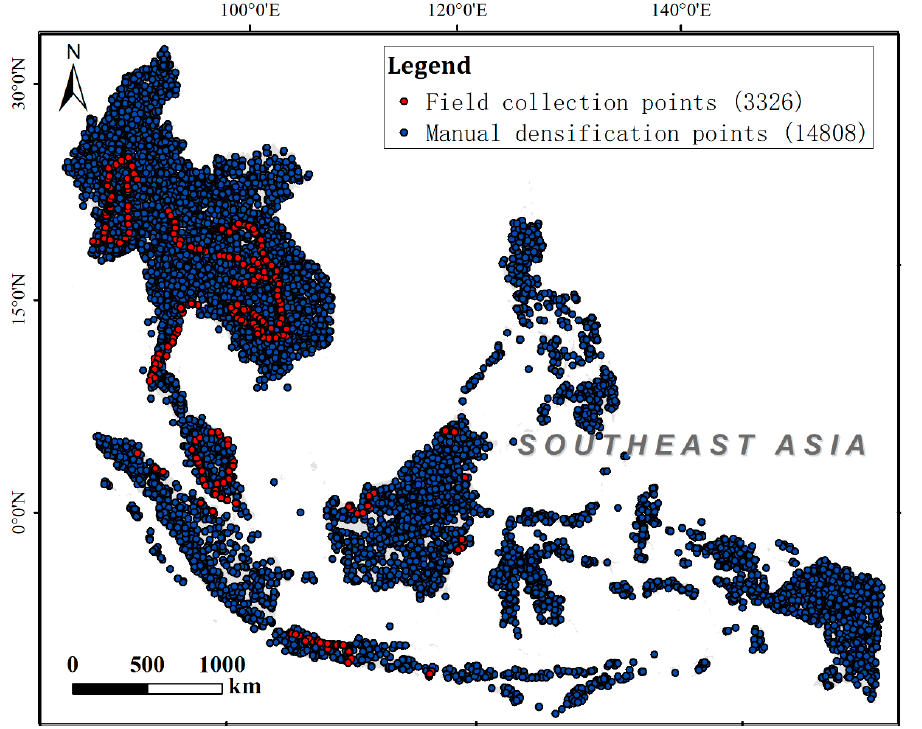
Figure 7. Distribution of the field collection points and consistent manual densification points. There are 18,134 points in total, including 3326 field collection points and 14,808 manual densification points. Among the manual densification points, there are 3971 cropland points, 6883 forest points, 1238 grassland points, 1061 shrubland points, 189 wetland points, 645 water points, 552 built-up area points, and 263 bare land points.